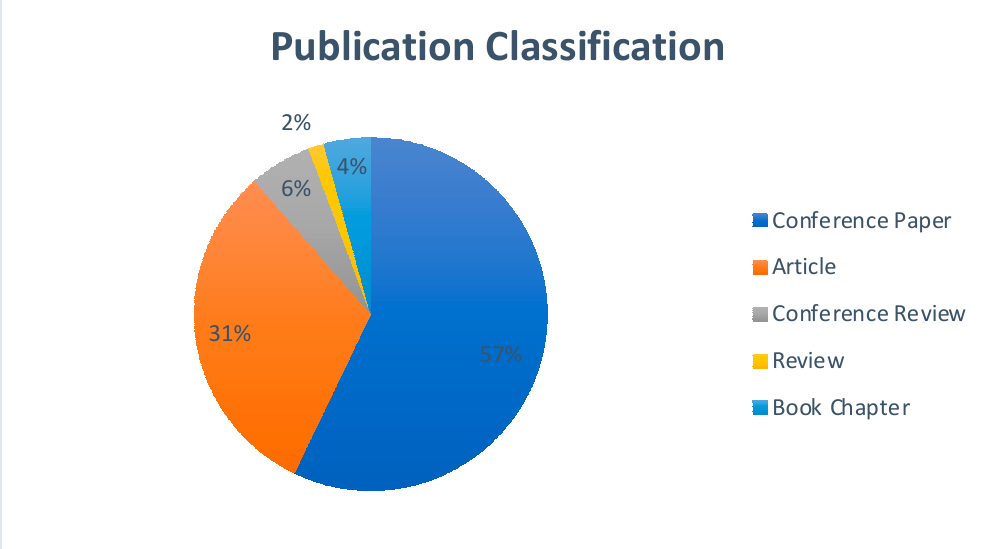
Figure 14. Publication classification comparison for Blockchain-as-a-Service.